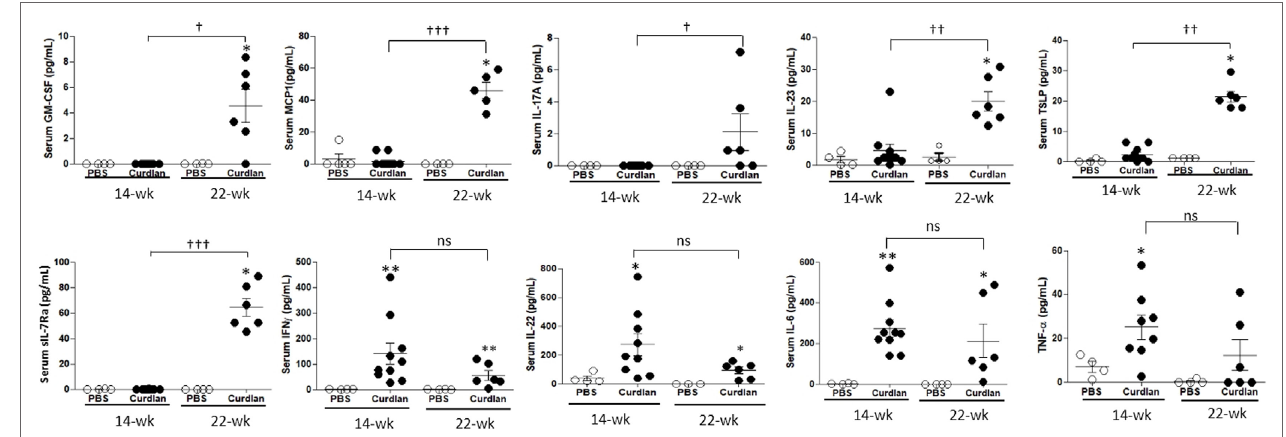
FigUre 4 | Levels of serum cytokines at week 14 and 22 post-injection in PBS- and curdlan-treated SKG mice. Values are mean ± SEM. * p < 0.05 and ** p < 0.01 between PBS- and curdlan-treated mice; † p < 0.05; and †† p < 0.01; ††† p < 0.001 between 14- and 22-week post-injection in curdlan-treated mice by Mann– Whitney U